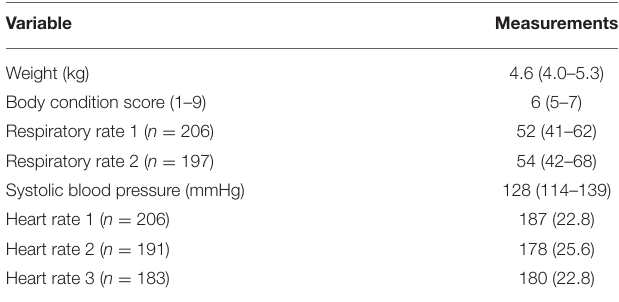
TABLE 2 | Summary of weight, BCS, and physiological parameters during clinical assessment conducted in 206 cats aged 7–10 y.